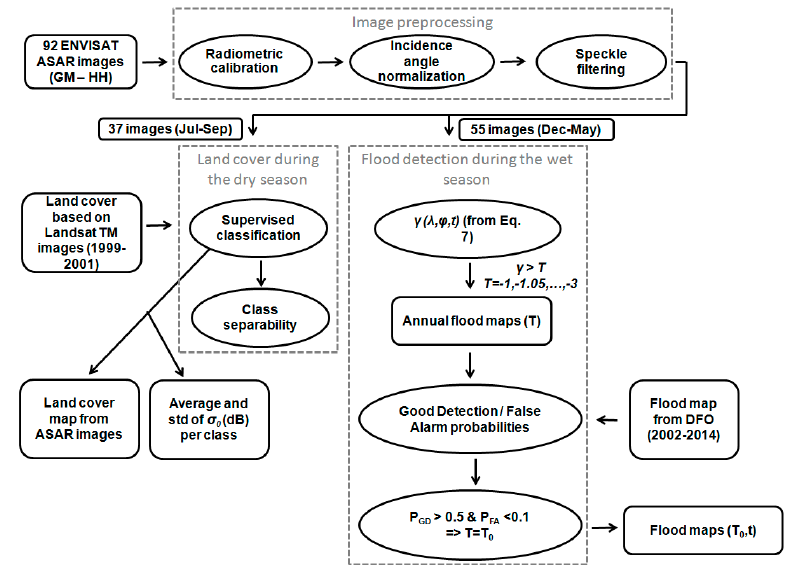
Figure 3. Schematic view of the processing of the ENVISAT ASAR images acquired in GM mode